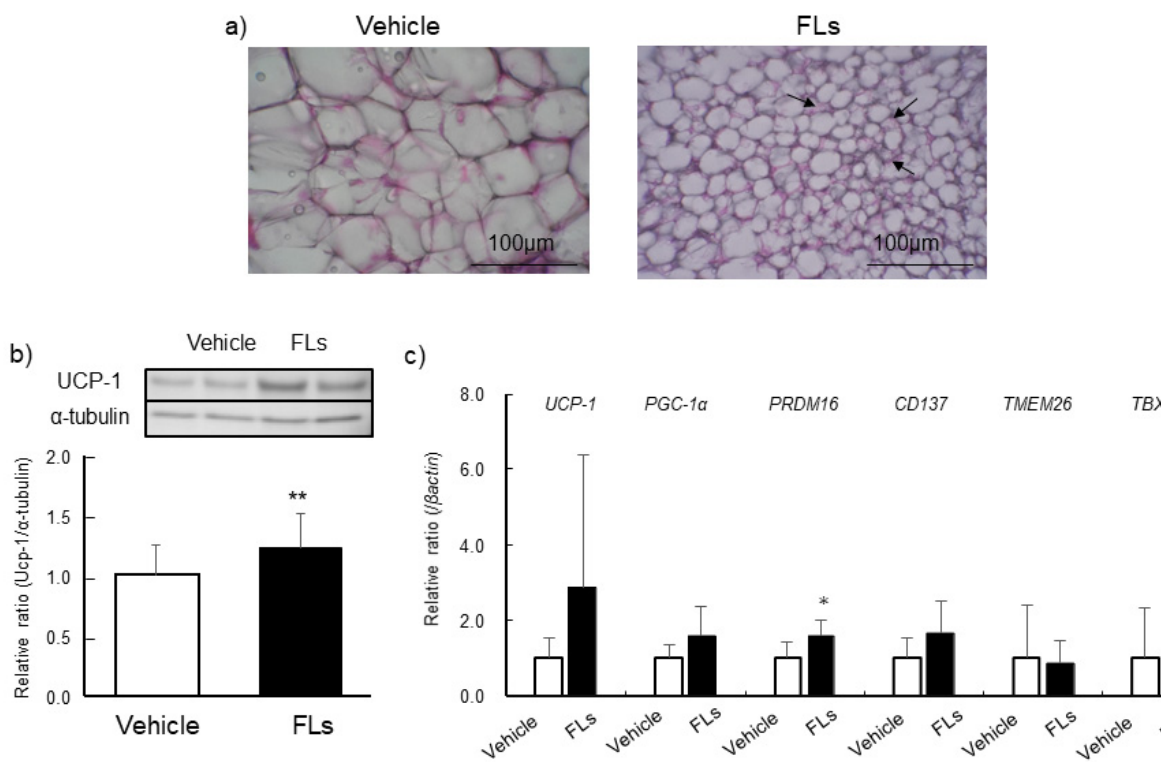
Figure 4. The impact of repeated oral administration of 50 mg/kg flavan 3-ols (FL)s on mice epididymal adipose (eWAT). Ucp-1 levels determined by western blotting ( a ), mRNA expressions of UCP-1, PGC-1 α , PRDM16, CD137, TMEM26 and TBX-1 ( b ). The values represent the mean ± standard deviation (each group, n = 11). # p < 0.1, * p < 0.05, ** p < 0.01 (Student’s t -test).